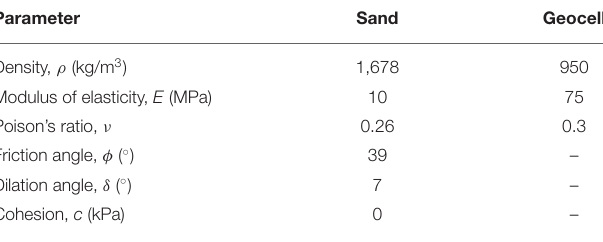
TABLE 1 | Input parameters used in the finite element model. Parameter